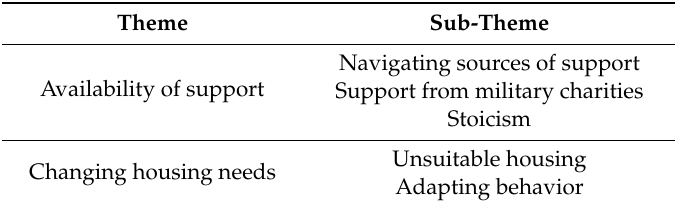
Table 2. Overarching themes and related sub-themes generated from the